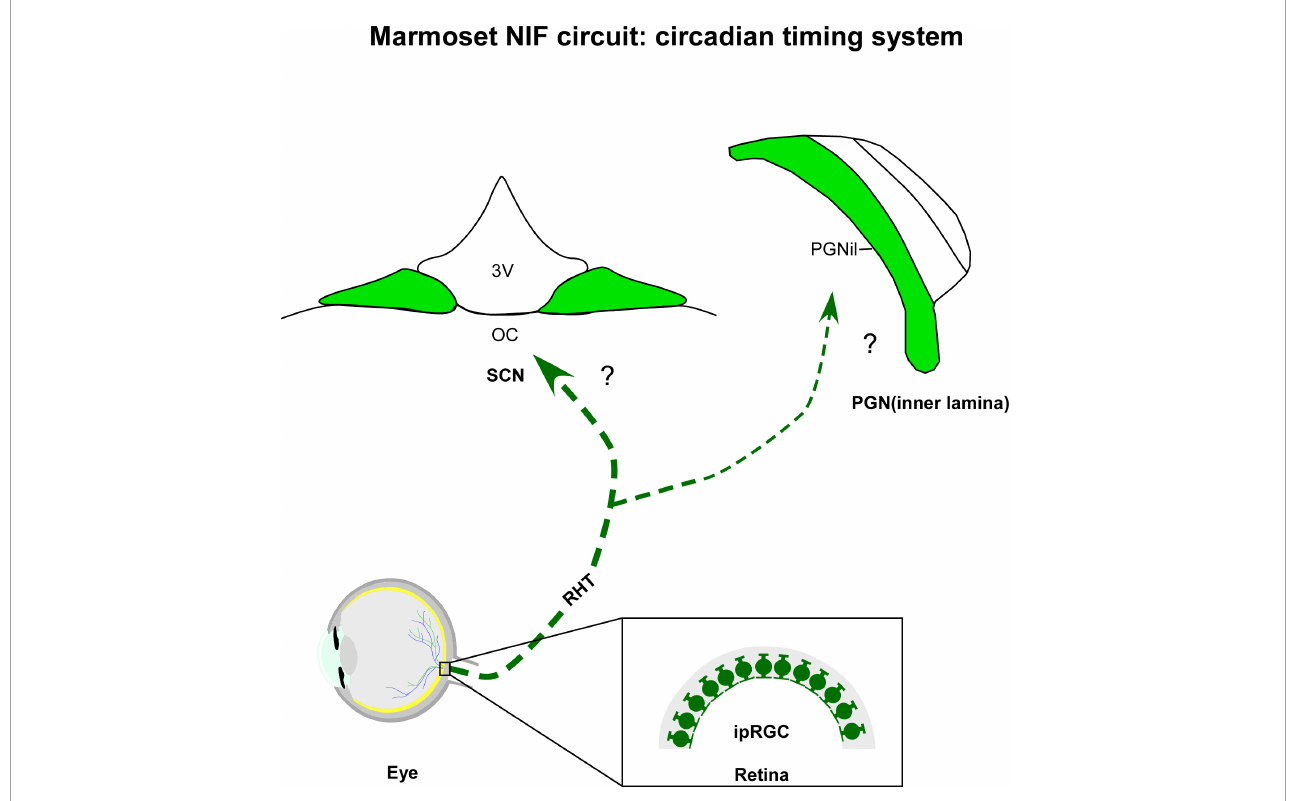
FIGURE2 Diagrammatic representation of the marmoset circadian timing system (green). The suprachiasmatic nucleus (SCN) and inner laminar of pregeniculate nucleus (PGNil) are retinorecipient structures involved with the biological rhythms. Note that although melanopsin-containing intrinsically photosensitive retinal ganglion cells (ipRGCs) were evidenced in marmoset retina, the retinal cell type(s) providing the input to circadian centers have not yet been identified. 3v, third ventricle; oc, optic chiasma; RHT, retinohypothalamic